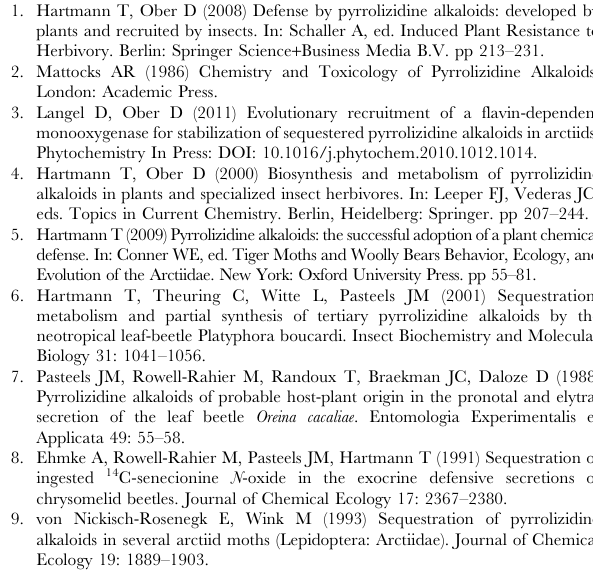
Figure S1 Amino acid alignment of flavin-dependent monooxygenases of various insect species. Only the central part of the alignment that was used for the estimation of the phylogenies is shown, spanning the region from amino acid position 5 to 402 with respect to Zv PNO. The sequence motifs for binding of FAD and NADPH and the FMO-identifying sequence are boxed. The accession numbers of the three FMO sequences of Zonocerus variegatus and of all sequences taken from the databases are given at the end of the alignment. (PDF) Figure S2 PNO activity in three buffer systems with pH variation. Enzyme activities have been determined with senecionine as substrate at 37 u C. (PDF) Table S1 Sequences of primers used for the identifica- tion and cloning of cDNAs of flavin-dependent monoox- ygenases of Zonocerus variegatus . Recognition sites of restriction endonucleases used for cloning are